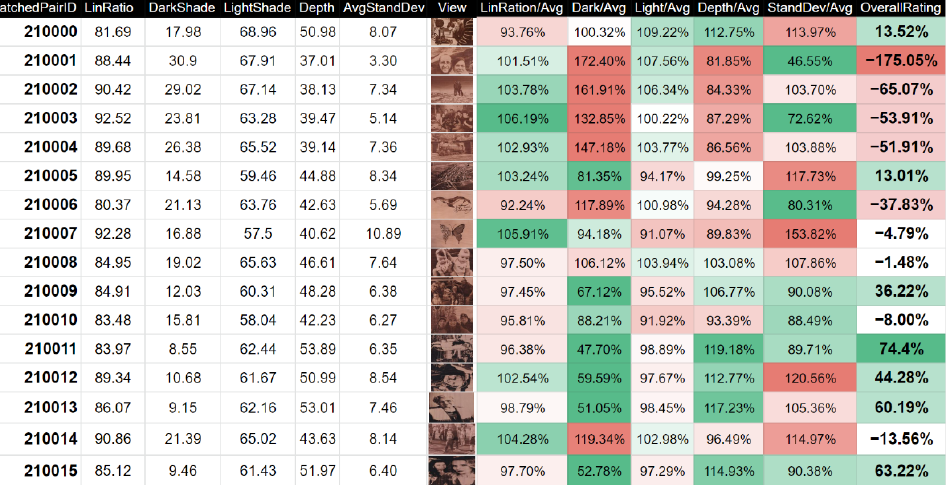
Figure 14. Quality calculations for scanned engraved